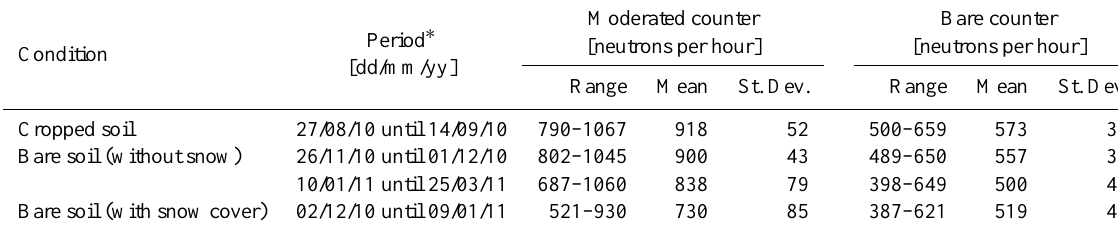
Table 3. Range of neutron counting rates observed in different field conditions.